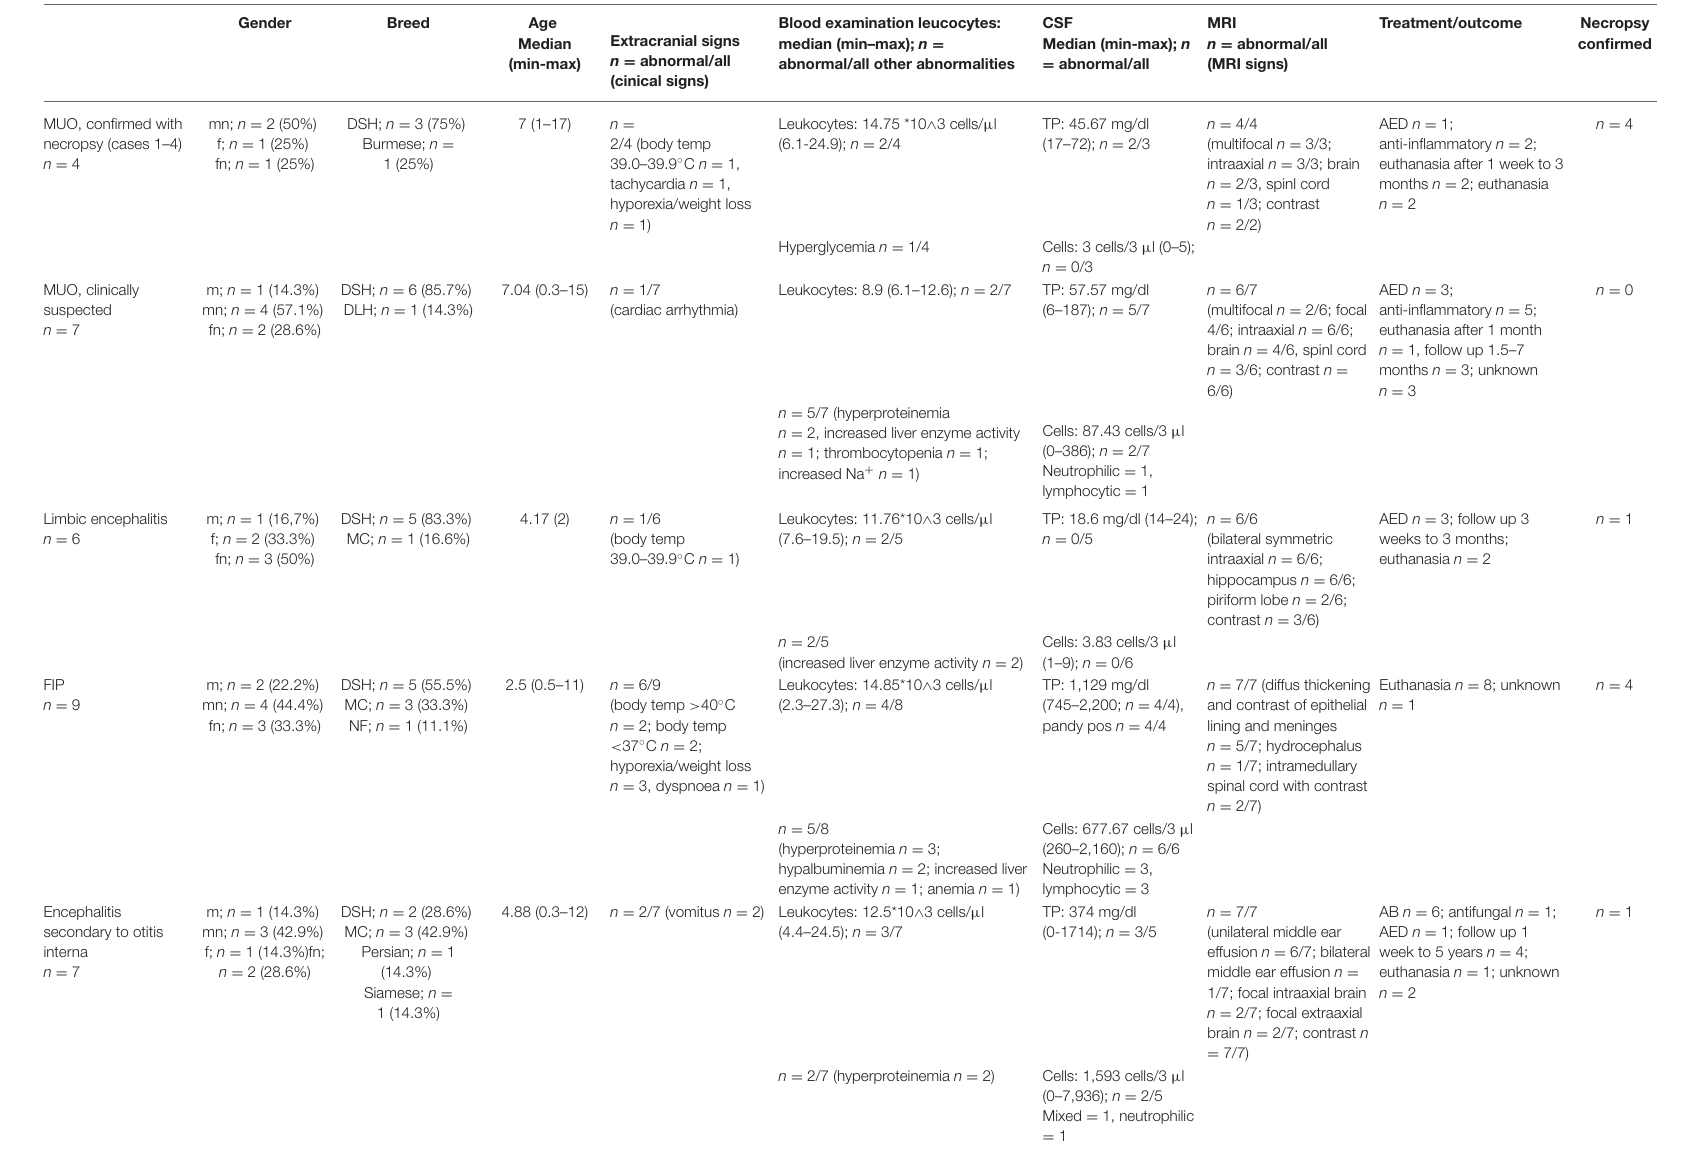
TABLE 1 | Cats with presumed and confirmed diagnosis of encephalitis (2012–2019): comparison between cats with necropsy confirmed MUO, clinically suspected MUO, other encephalitides and clinic population. Gender Breed Age